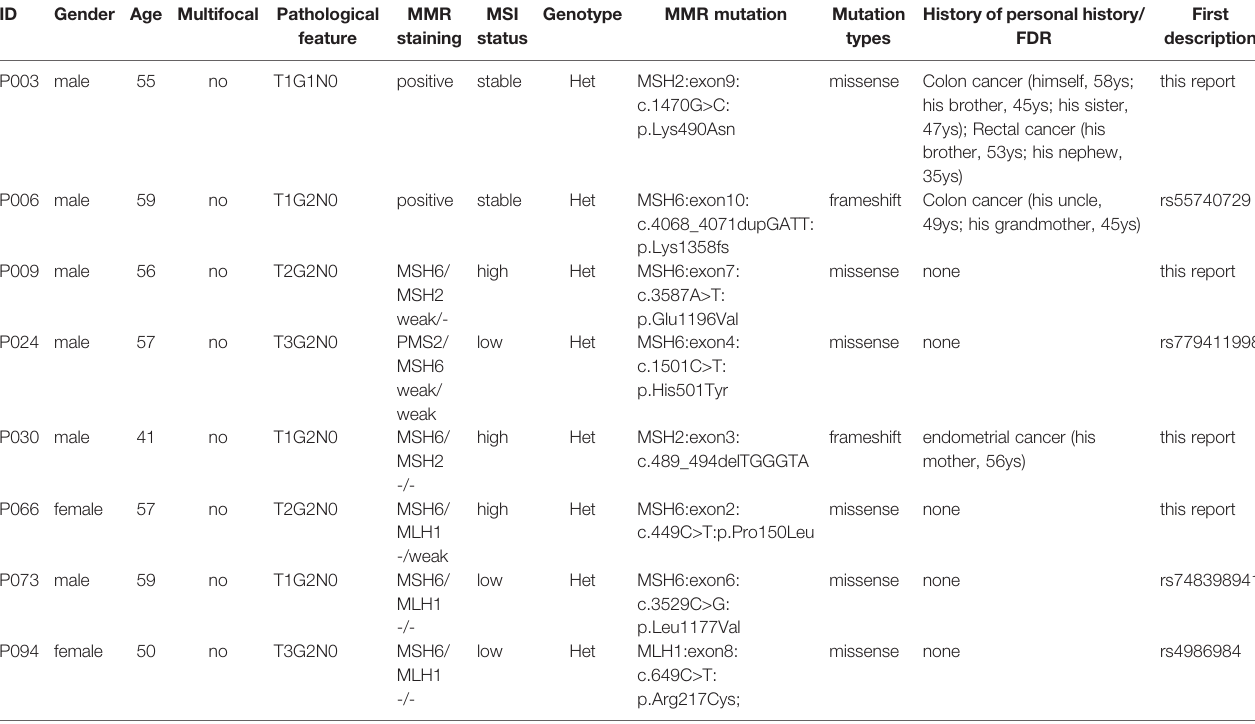
TABLE 2 | Germline MMR mutations with variant of uncertain signi fi cance in 38 patients who underwent whole exon sequencing. ID Gender Age Multifocal Pathological feature